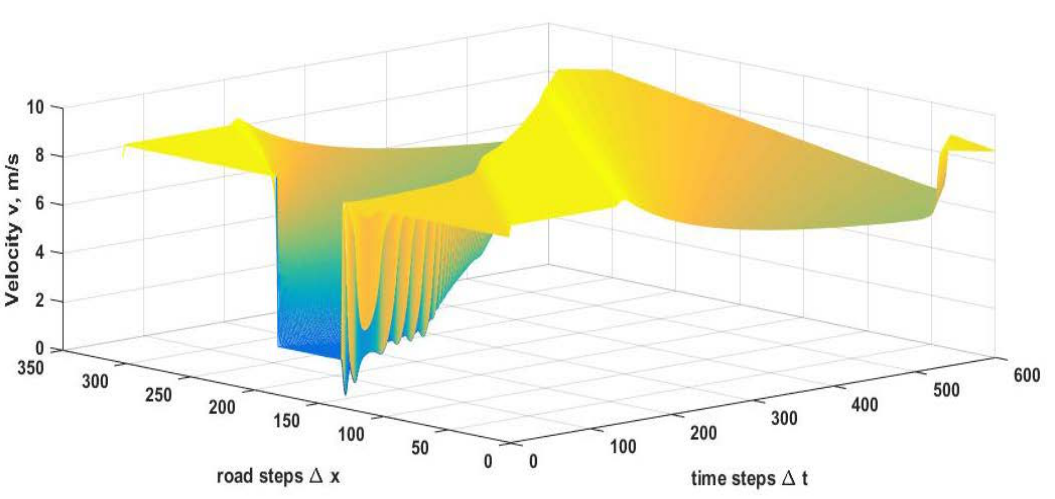
Figure 8. Velocity with the proposed model during congestion ( ρ > 0.5) over a 300 m circular road with τ = 2.5 s and h = 20